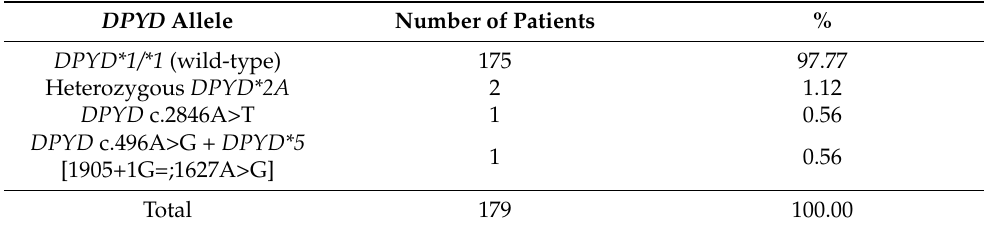
Table 2. DPYD allele frequencies in the whole